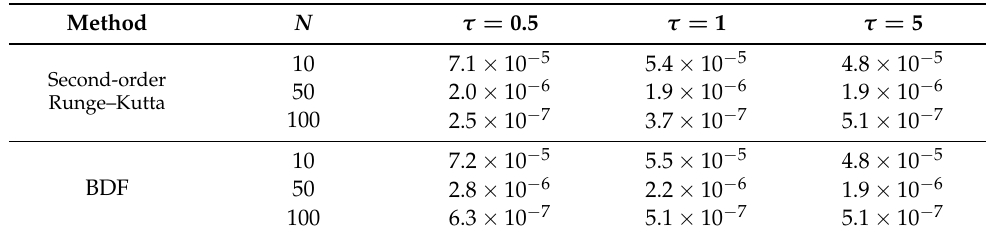
Table 3. The relative errors of the numerical solutions of test problem 3 for a = 1, k = 0.5, and three different delays τ on the interval 0 ≤ t ≤ T = 50 τ